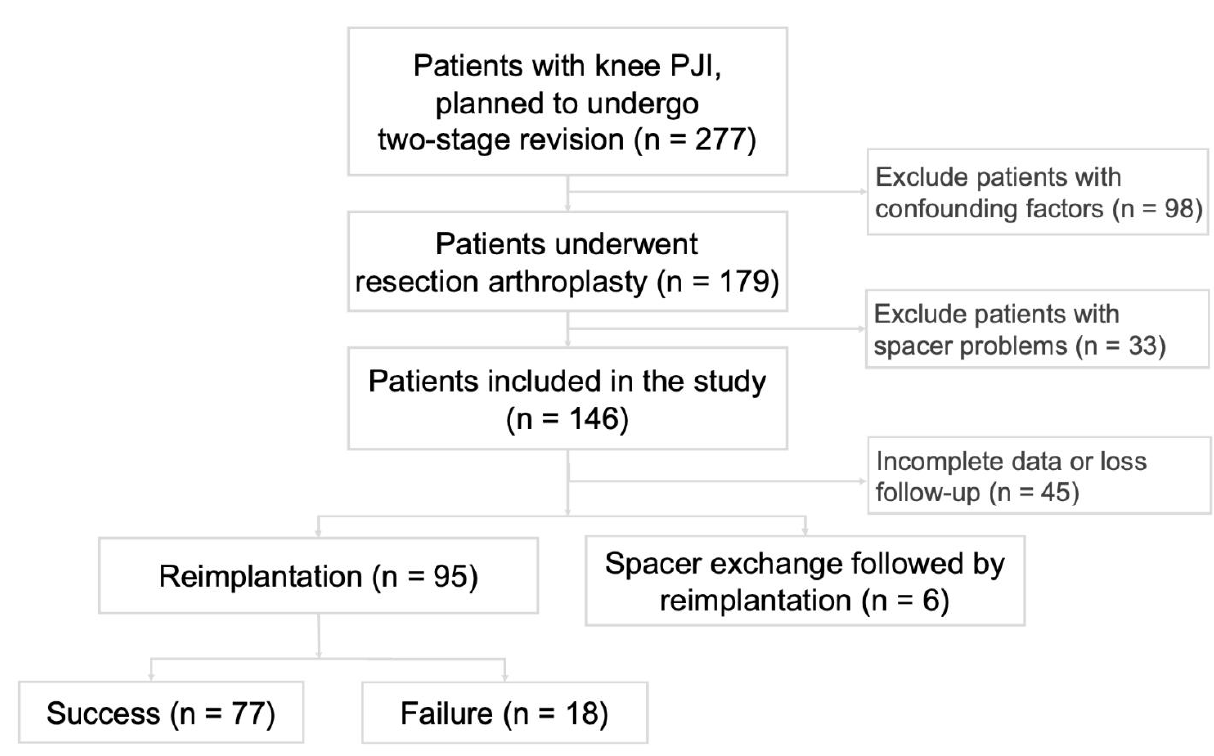
Figure 1 . Patient enrollment algorithm. Three out of six patients who had spacer exchange did not have infection recurrence, but still considered treatment failure according to Delphi criteria. Table 1. Definition of periprosthetic joint infection. It was a scoring-based definition adopted by the Musculoskeletal Infection Society [27].